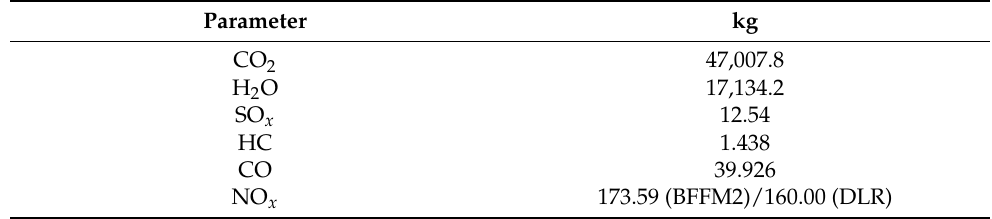
Table 2. Estimated CSR-01 emissions for the selected